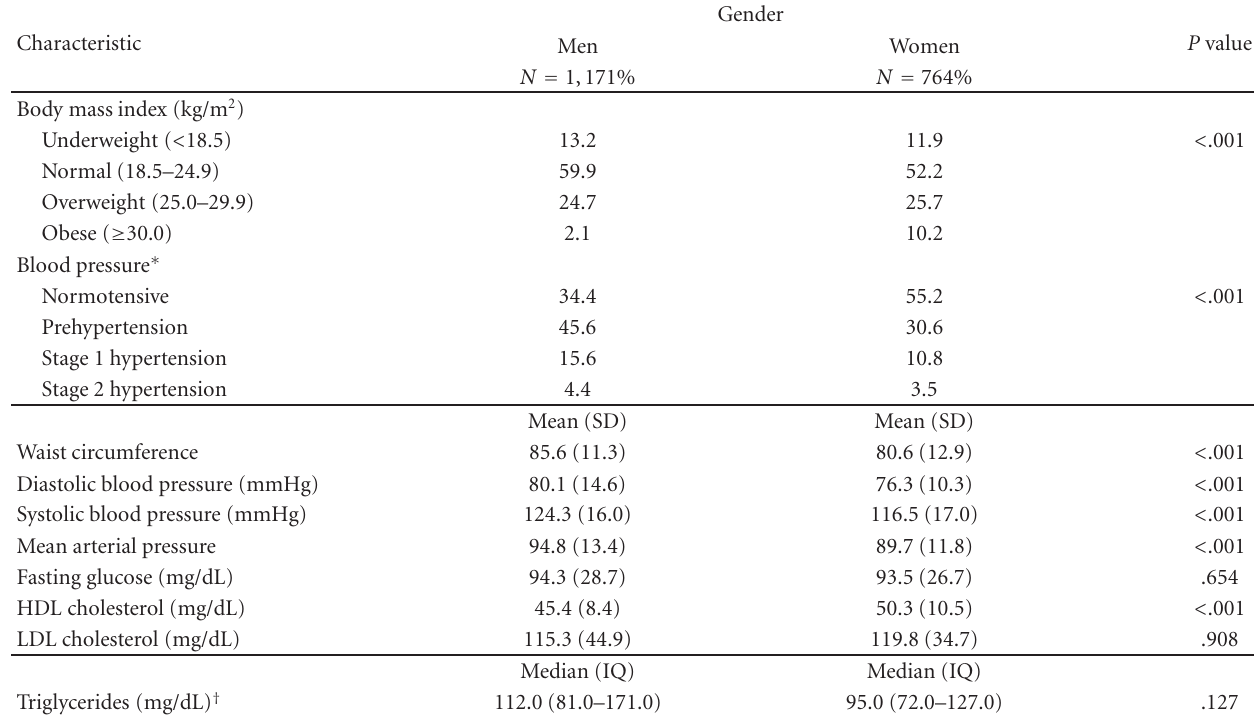
Table 2: Cardiometabolic characteristics of study population according to gender.